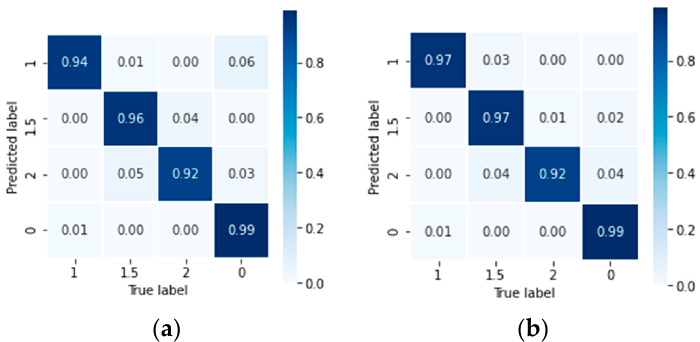
Figure 12. The normalized confusion matrix of test datasets from ( a ) M1; ( b ) M2.